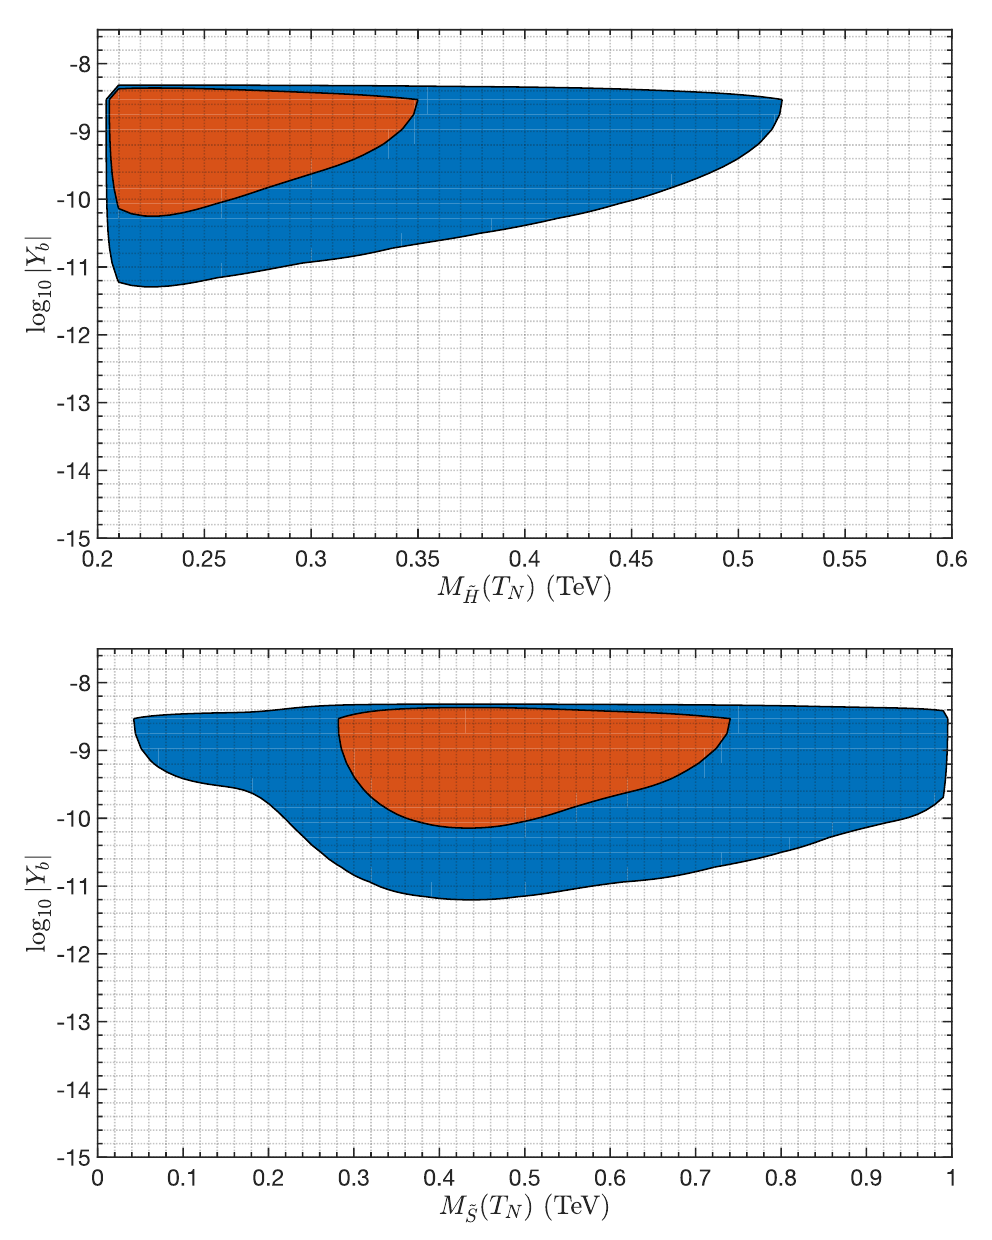
Figure 1 . Two dimensional posterior probability distribution in the baryon asymmetry, produced by the maximum CP-violating phase in the SSPT (singlet simultaneous) scenario, and the thermal mass of the Higgsino (top panel) and singlino (bottom panel). We colour the 1 (cid:27) and 2 (cid:27) credible regions in orange and blue,